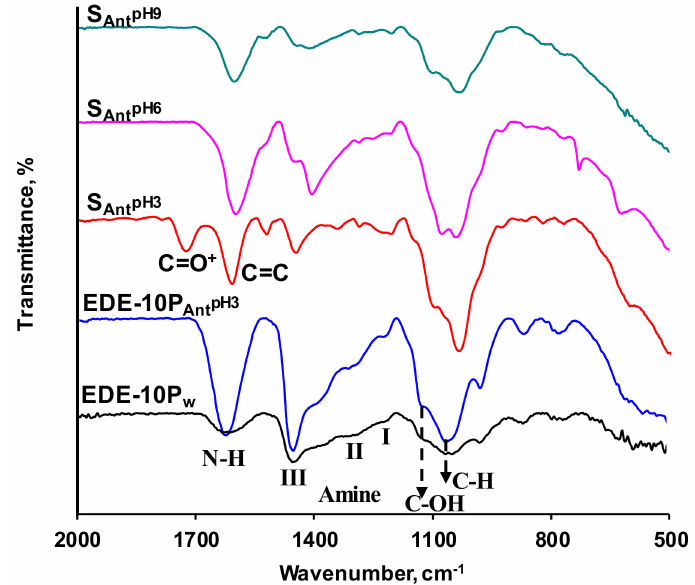
Figure 5. IR spectra of the EDE-10P samples equilibrated with deionized water (indicated by the subscript W) and an anthocyanin solution at pH 3 (indicated by the subscript AntpH3 ). The IR spectra of the anthocyanin solutions at pH 3, 6, and 9 (indicated by the subscript S AntpHi ) are shown for